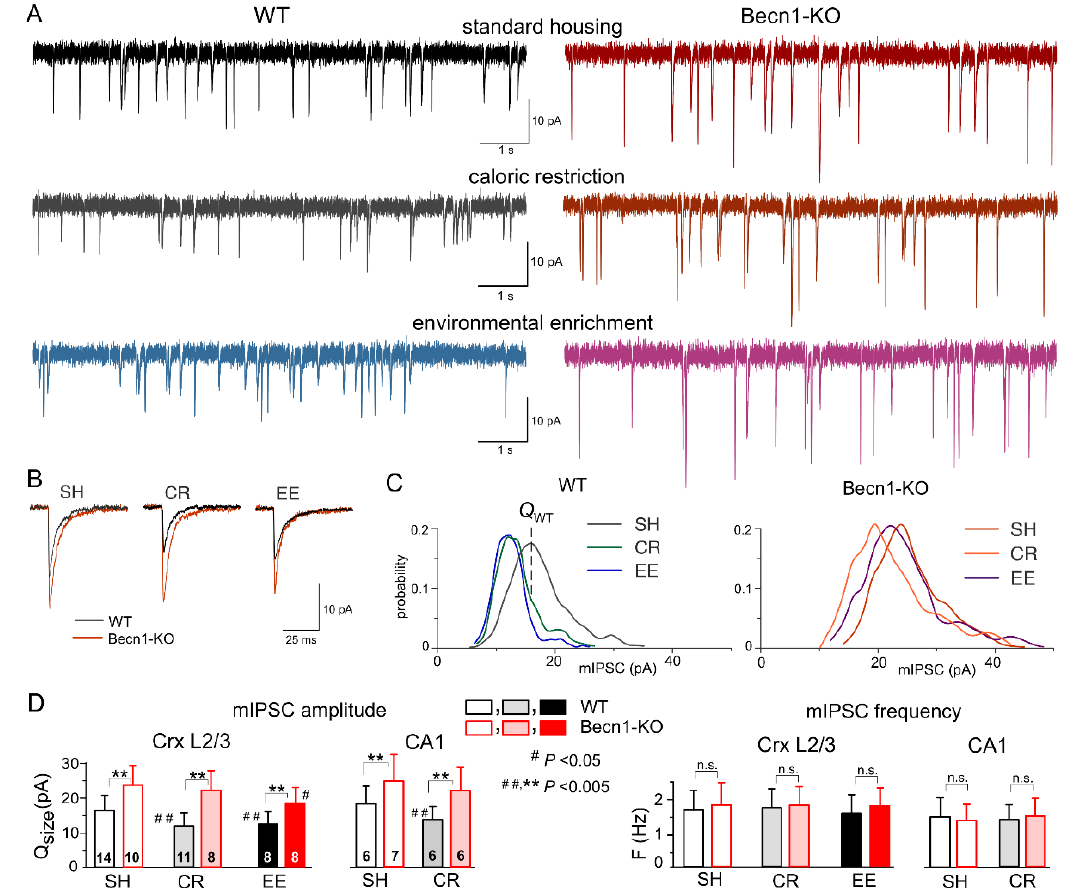
Figure 3. Impact of autophagy impairment on baseline inhibitory synaptic transmission and home- ostatic synaptic plasticity. GABA A receptor-mediated miniature inhibitory synaptic currents (mIP- SCs) were recorded in the neocortical and hippocampal pyramidal neurons at −80 mV in the pres- ence of 30 µM DNQX, 1 µM TTX and 10 µM PPADS. ( A ) The representative whole-cell currents